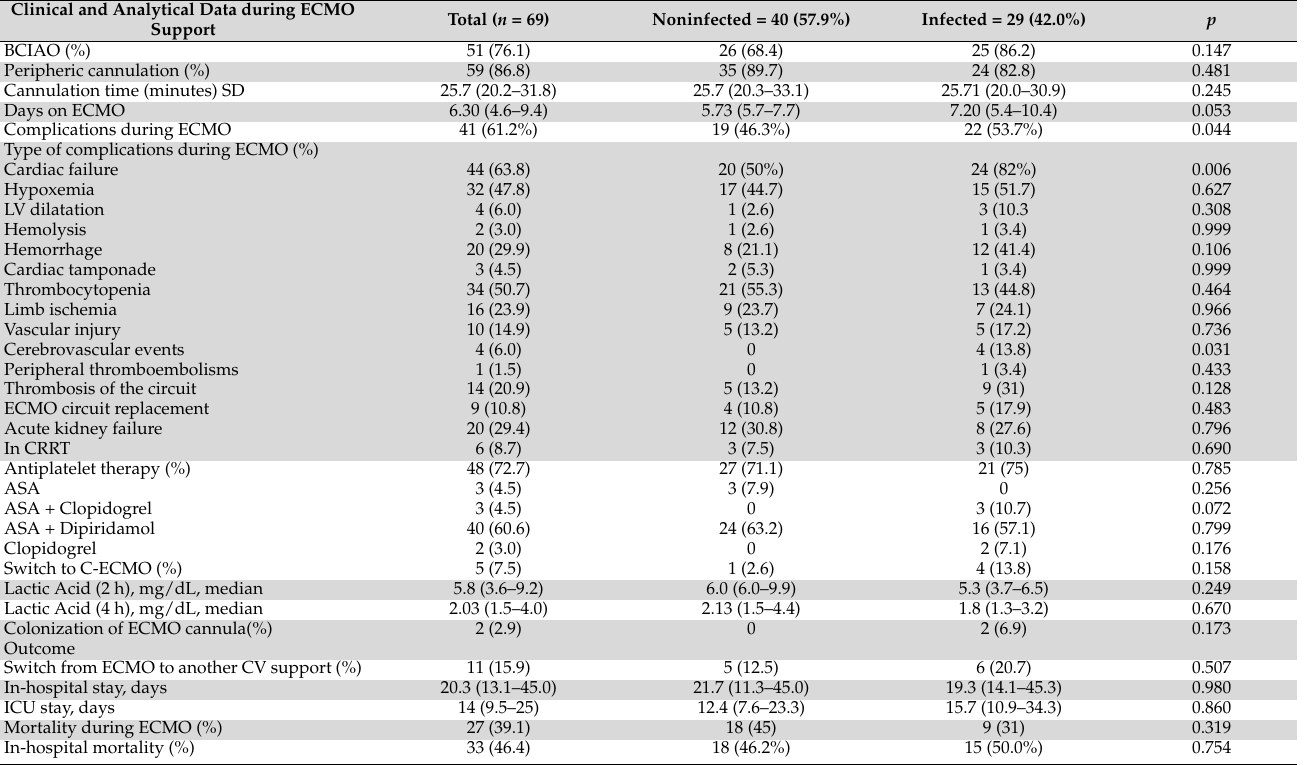
Table 2. Clinical and analytical data between patients with and without nosocomial infections supported by VA-ECMO during extracorporeal membrane oxygenation